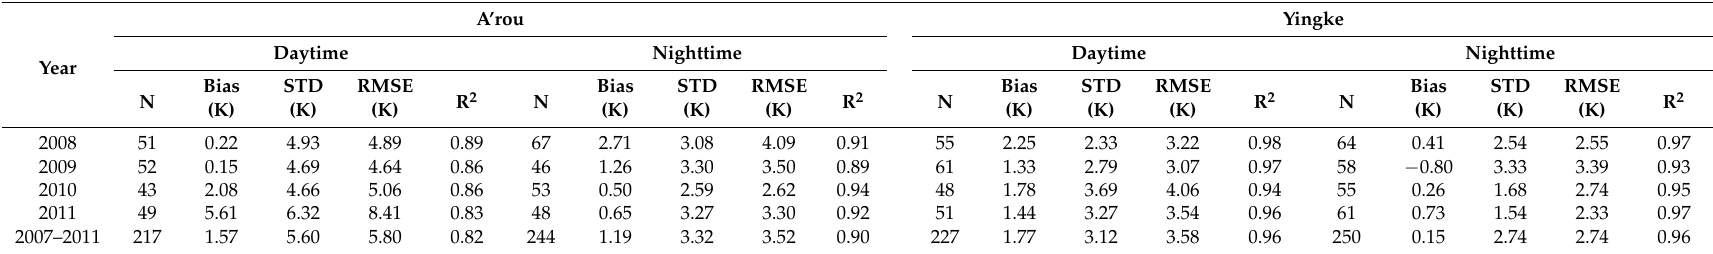
Table 2. Bias, standard deviation (STD), root mean square error (RMSE), and correlation coefficient R-squared of the AATSR-derived LST vs. in situ LST over A’rou and Yingke site for 2007–2011.